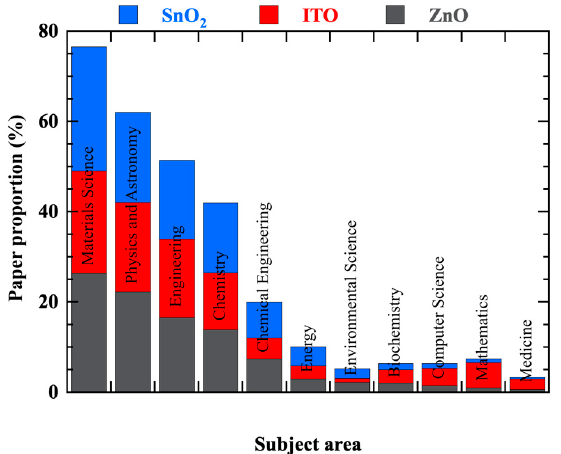
Figure 2. Publications on the three most studied TCOs by different subject areas over the last two decades.